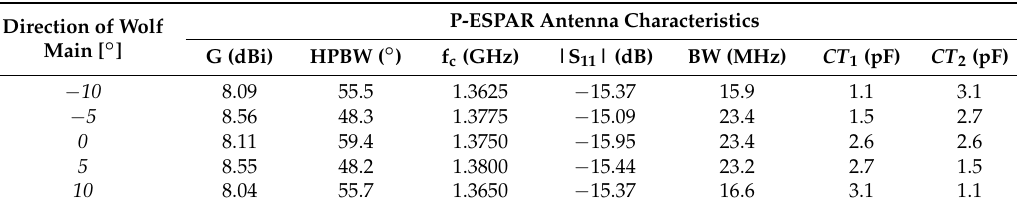
Table 9. Results of the P-ESPAR antenna simulation with FR-4 using varicap diodes BBY53-03W.